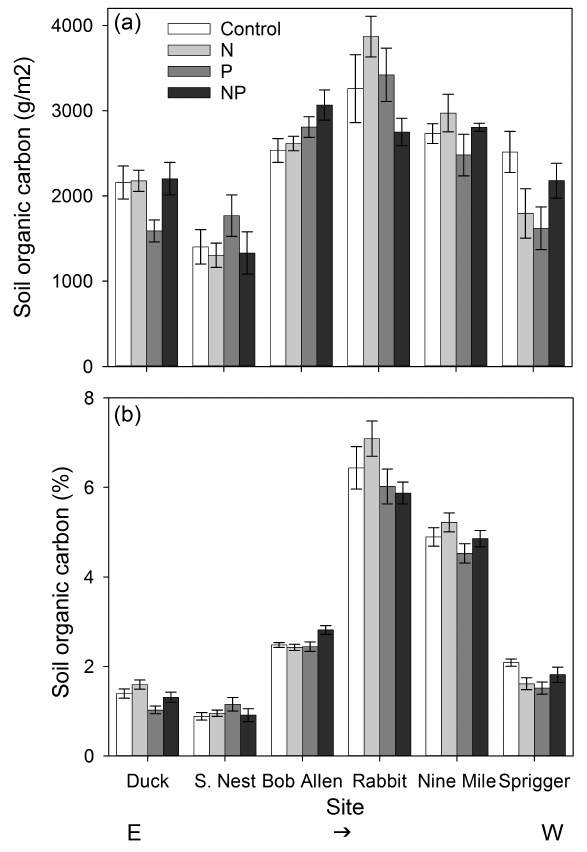
Figure 3. Soil organic carbon stocks, reported in (a) gm − 2 and (b) percent at six sites in response to nitrogen (N) and phospho- rus (P) addition. Sites are displayed along a naturally occurring P- availability gradient from low P availability in the east to high P availability in the west. Table 4. Results of 3-way ANOVA of site, nitrogen (N), and phos- phorus (P) addition on percent organic carbon in the soil.